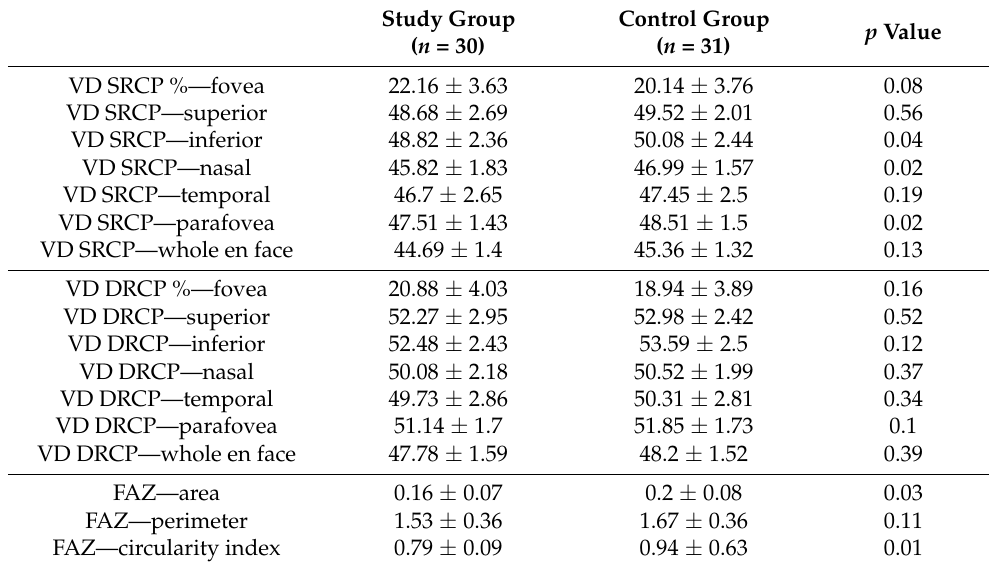
Table 3. Comparison of OCTA parameters.